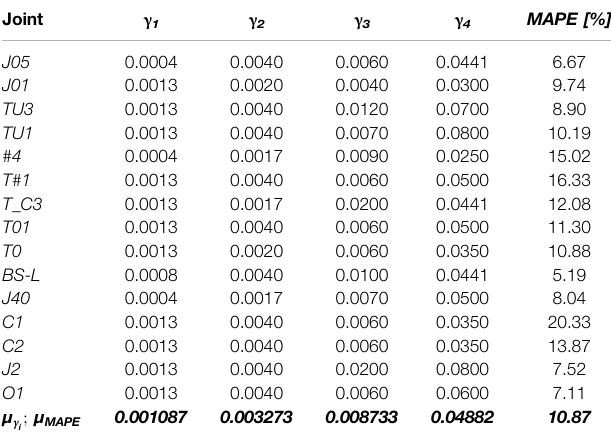
TABLE 6 | Strain parameters minimizing the mean absolute percentage